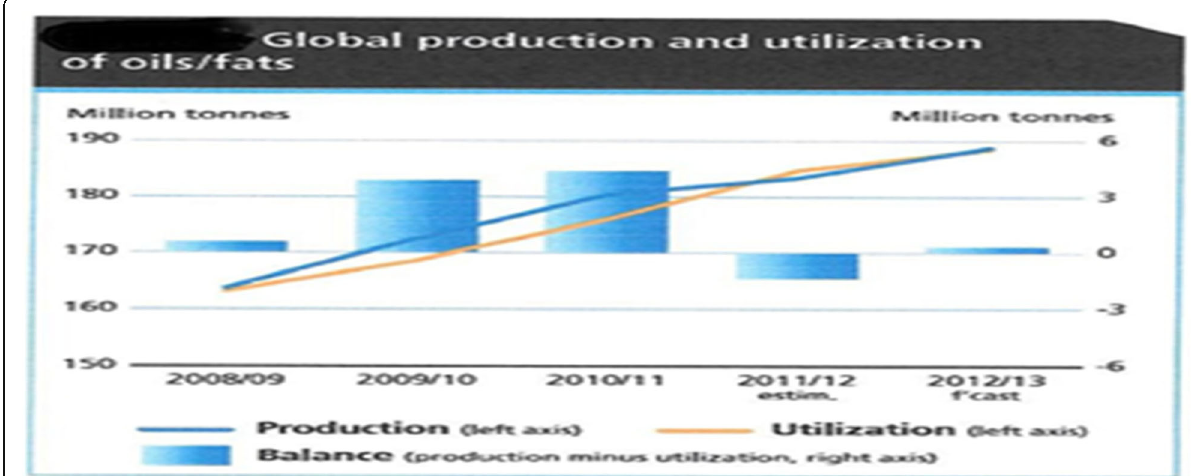
Fig. 4 Global production and utilization of oils/fats. [Source: FAO (FAO-Trade and Markets Division,